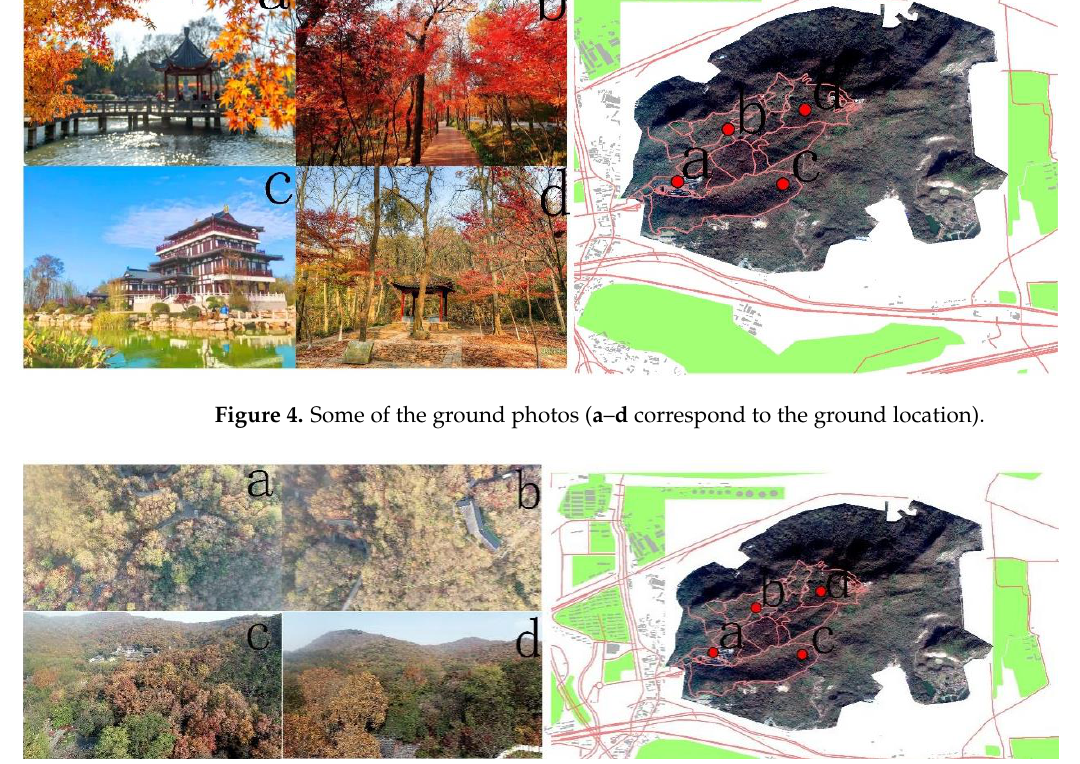
Figure 5. Some of the aerial photos ( a – d correspond to the aerial location).